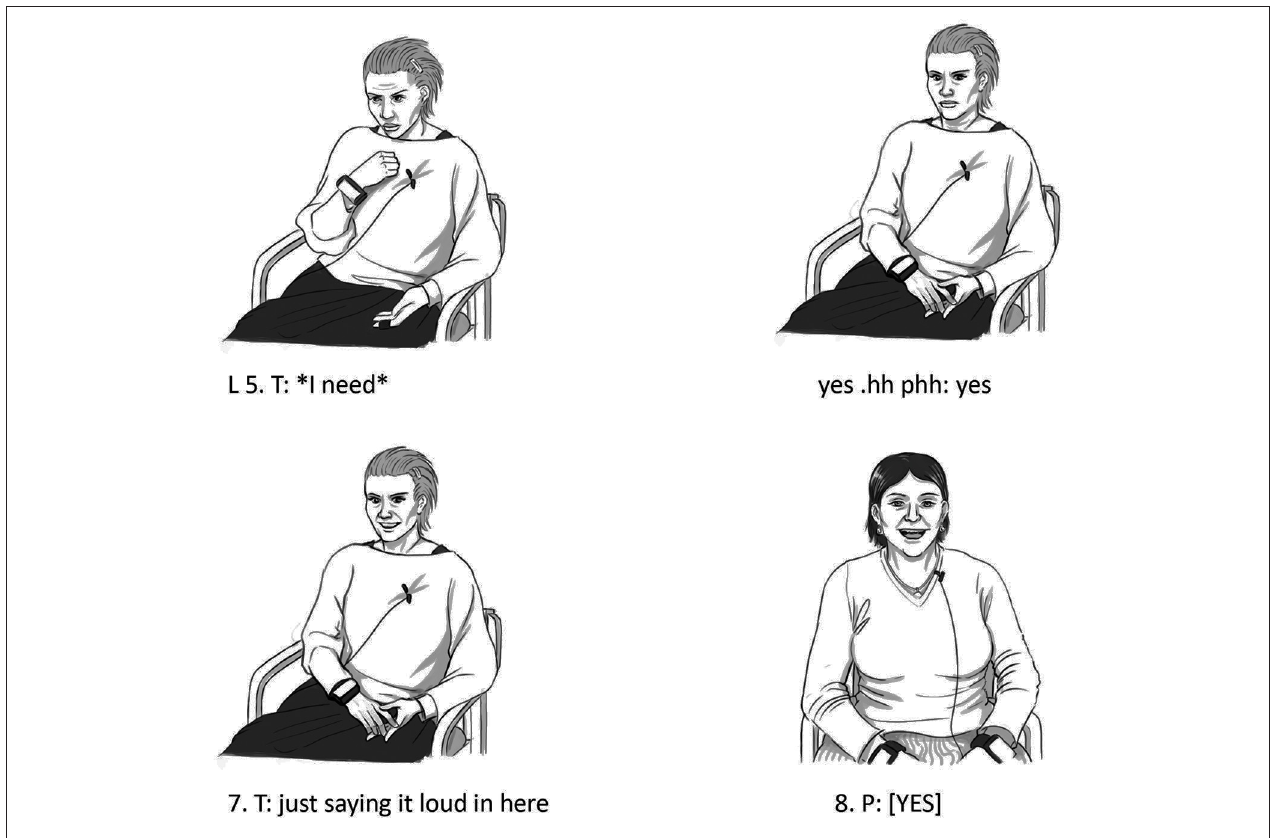
FIGURE 3 | Bodily actions in relation to example 3.